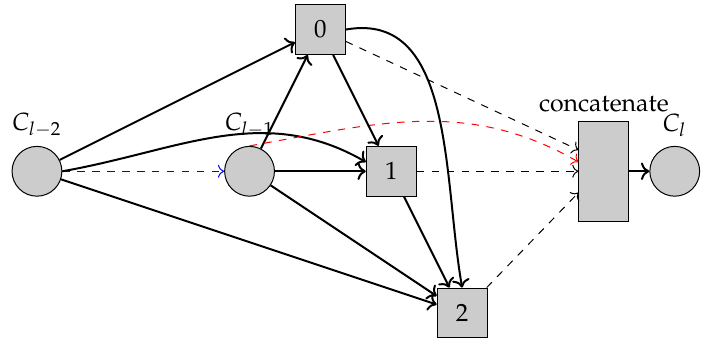
Figure 4. Cell-level search space. The cell output C l is computed using the previous 2 cell outputs C l − 2 , C l − 1 . The intermediate nodes are shown as 0,1,2, and for each input connection to these nodes, an operation will be searched for. The red dashed arrow shows the residual connection and the blue dashed arrow shows the previous cell that uses C l − 2 as one of its inputs to compute C l − 1 . The intermediate nodes are concatenated, shown with black dashed arrows to obtain the final output C l